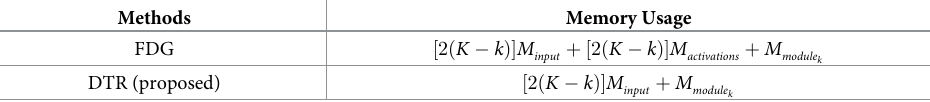
Table 2. M input , M activations , and M represent the memory space taken by one batch of input feature and acti- module k vation graphs, and memory space taken by module k